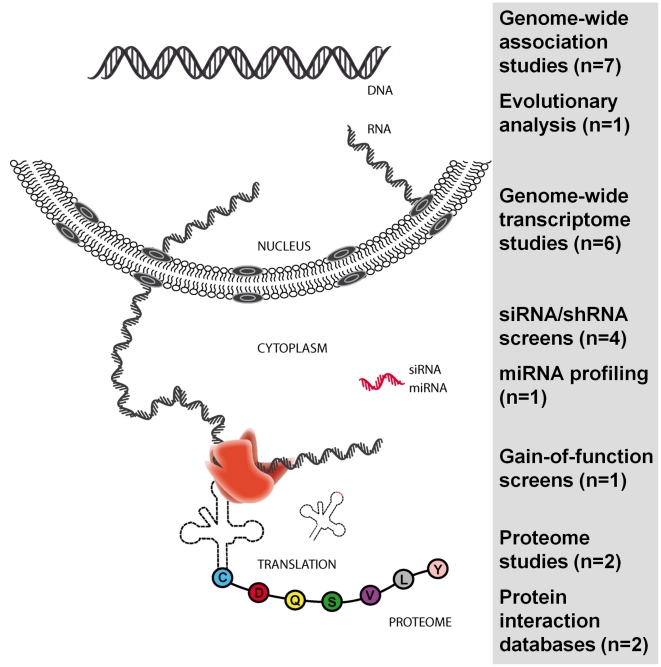
Genome-wide and large-scale studies published since 2007 in the HIV field.The number of studies is in parentheses. Diverse sets of results and data are compiled in an encyclopedia of overlaps between studies (http://www.hostpathogen.org/). This approach serves to identify networks used by HIV-1 to support its replication. Figure updated from reference [55] (http://F1000.com/Reports/Biology/content/1/71).